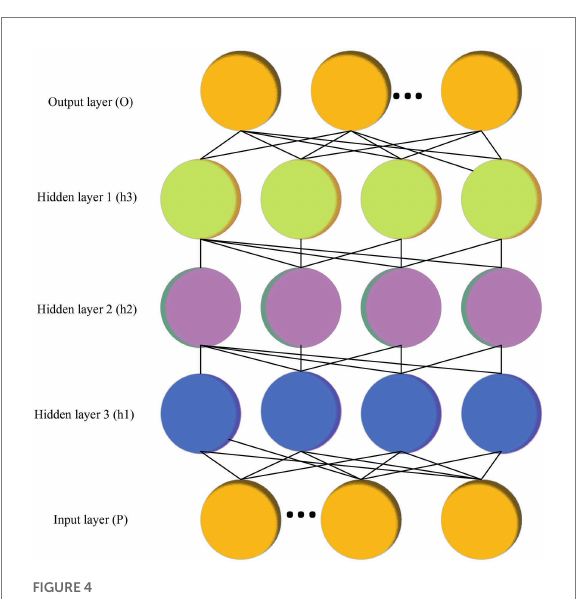
FIGURE 3 AE NN model.